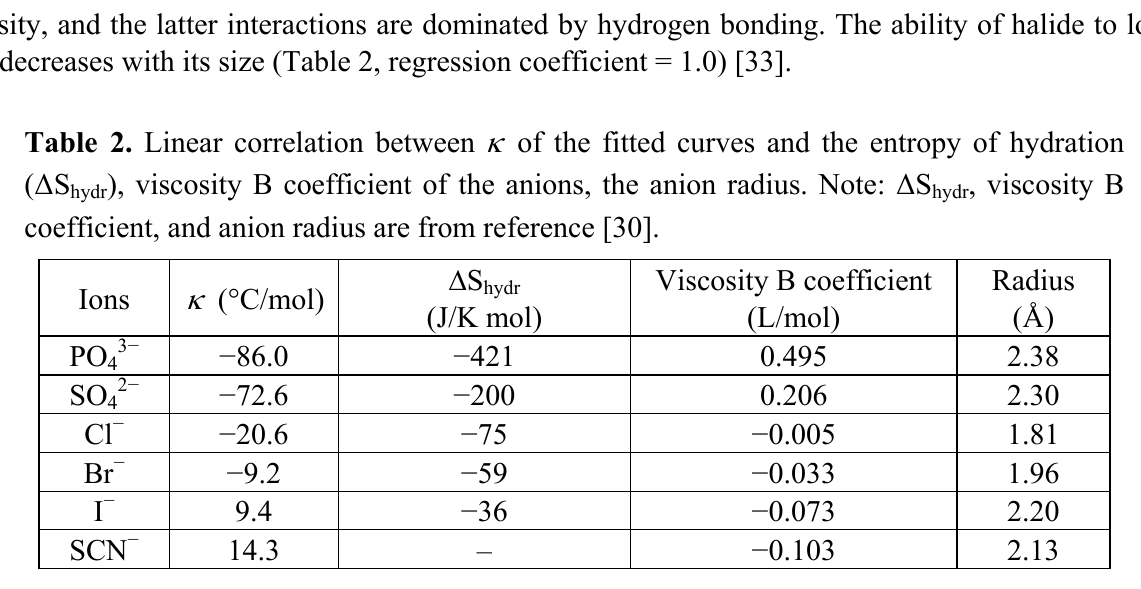
, viscosity B hydr